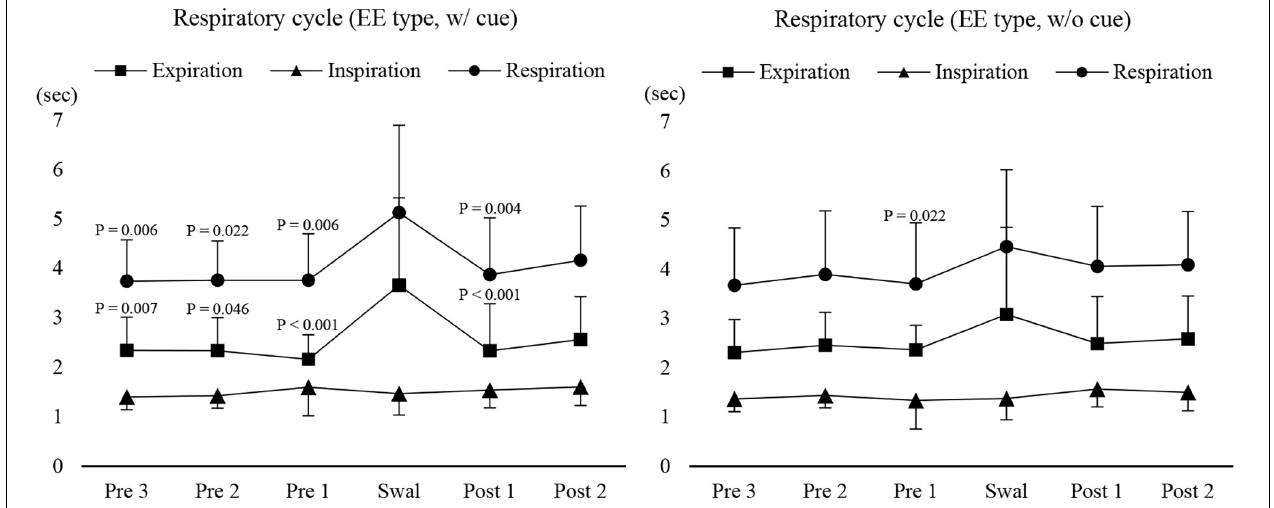
FIGURE 5 | Changes in respiratory, inspiratory, and expiratory time before, during, and after 3-ml water swallowing (expiration–swallow–expiration type, EE type) with (w/cue) and without cue (w/o cue). Swallowing apnoea time was excluded. With cue, the expiratory time was significantly longer during swallowing (Swal) compared with before (Pre) and after (Post) swallowing (one-way repeated measures ANOVA on ranks followed by Tukey test, P < 0.001). This was also the case for the respiratory time, which was significantly longer during swallowing compared with before (Pre 1–3) and after (Post 1) swallowing (one-way repeated measures ANOVA on ranks followed by Tukey test, P < 0.001). The results of post hoc test are shown in the figure. Without cue, there was a significant difference only between before (Pre 1) and during swallowing (Swal) for the respiratory time (one-way repeated measures ANOVA on ranks followed by Tukey test, P = 0.025).